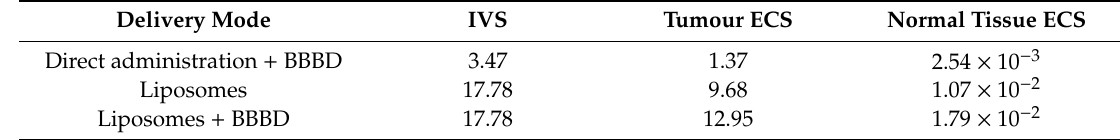
Table 4. AUC 24h (mg / mL · s) with di ff erent delivery